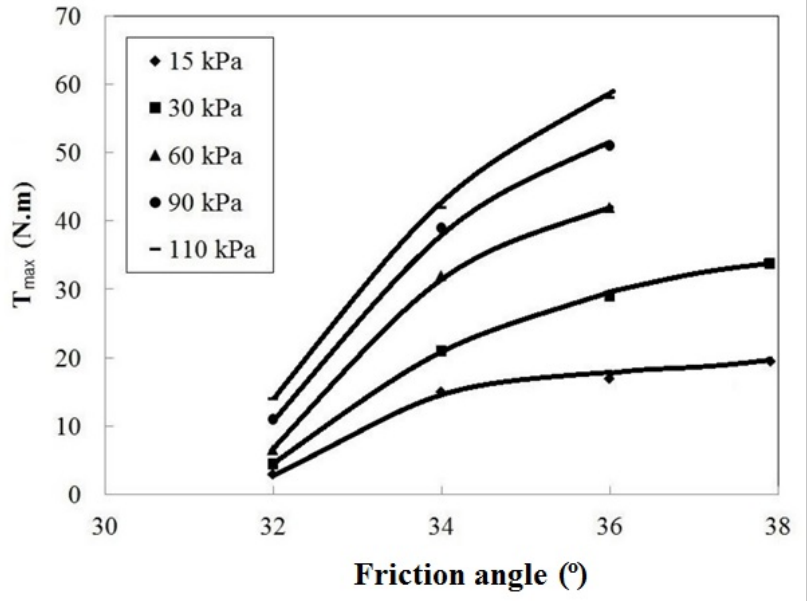
Figure 10. Relationship between the peak friction angle and T max for different overburden